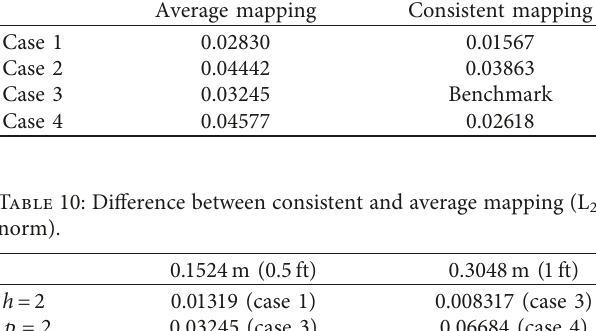
Table 9: L 2 error norm for cases 1 to 4.